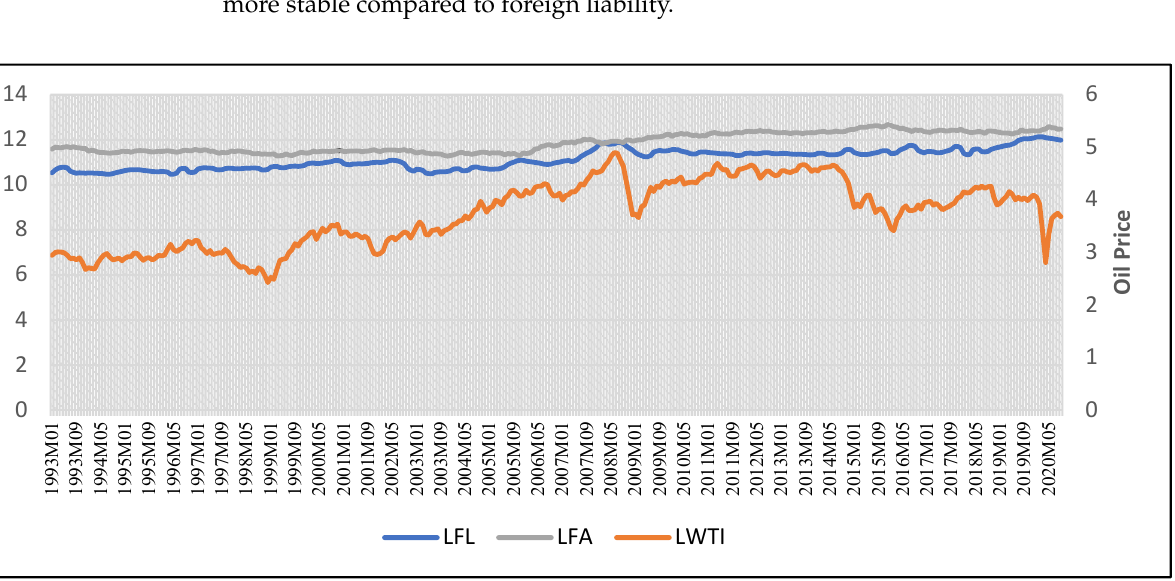
Table 1. Description of variables.